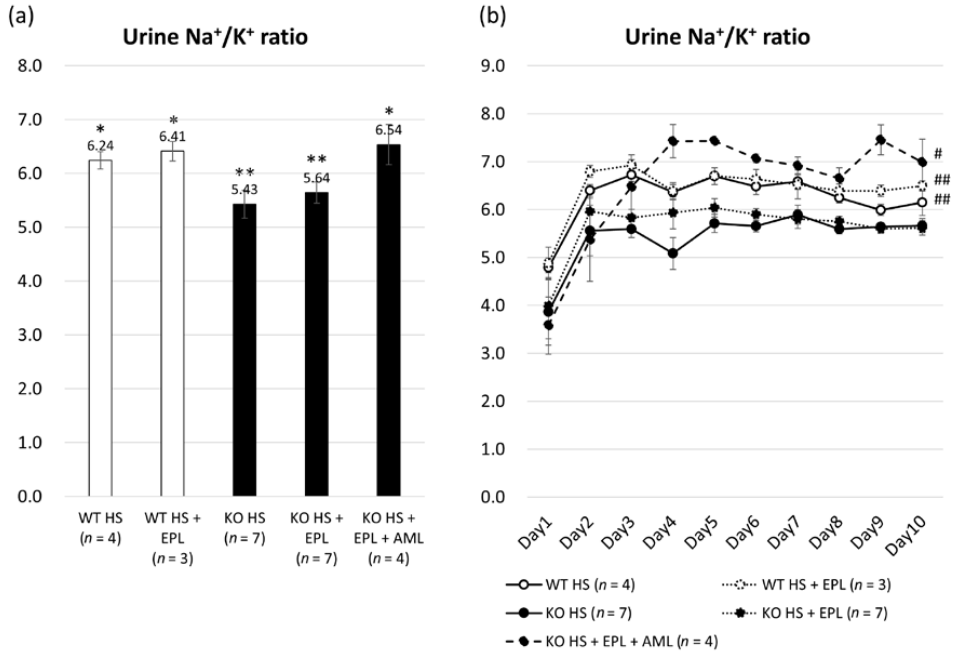
Figure 3. Na + /K + ratio calculated from urine Na + and K + concentrations. ( a ) Averages of total Na + /K + ratio in each group analyzed by one-way ANOVA; ( b ) Averages of Na + /K + ratio from days 1 to 10 in each group analyzed by two-way repeated ANOVA. Data are from wild-type mice on a high-salt diet ( n = 4), wild-type mice on a high-salt plus EPL diet ( n = 3), Nedd4-2 C2 KO mice on a high-salt diet ( n = 9), and Nedd4-2 C2 KO mice on a high-salt plus EPL diet ( n = 9). * p < 0.01 compared with KO HS and KO HS + EPL; ** p < 0.01 compared with WT HS, WT HS + EPL, and KO HS + EPL + AML. # p < 0.05 compared with KO HS and KO HS + EPL; ## p < 0.05 compared with KO HS.